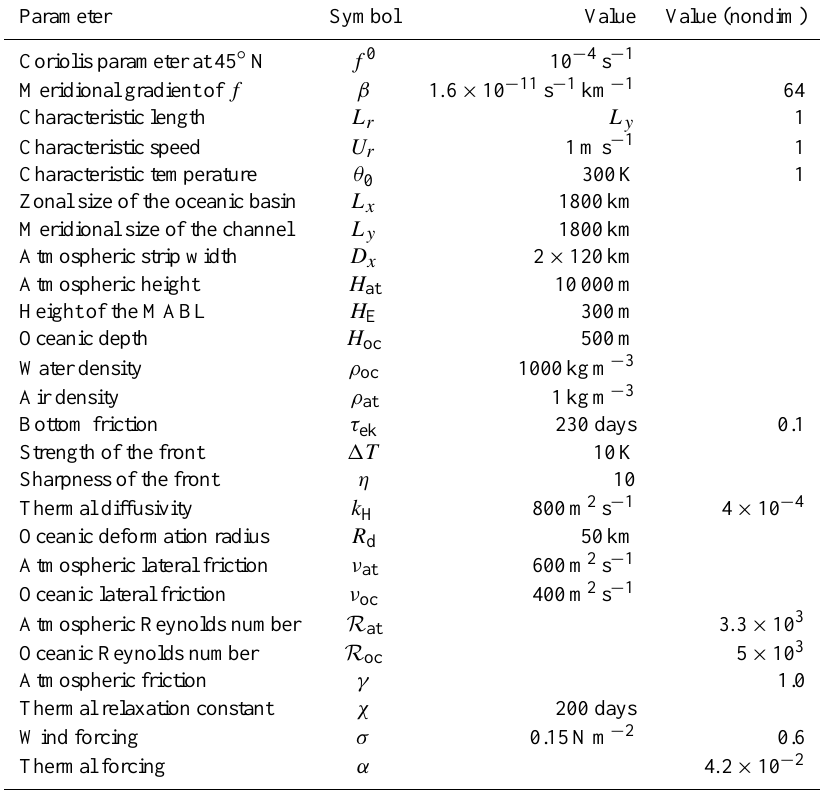
Table 1. Model parameter values used in the standard